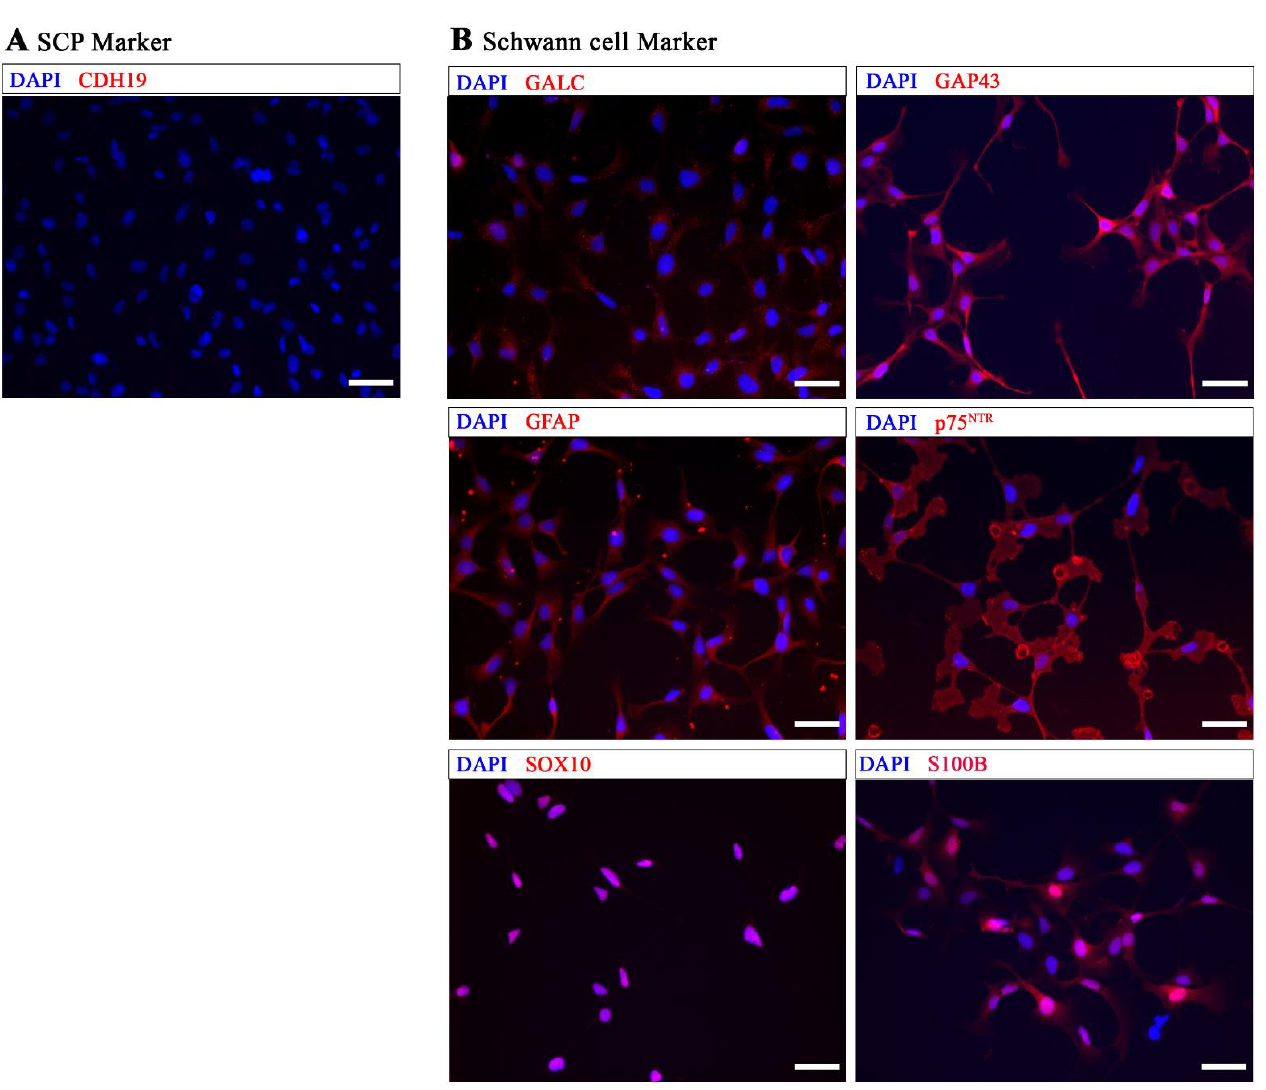
Figure 2. Immunocytochemical analysis of MHH-hiPSC-immatureSCs. ( A ) shows that hiPSC- immatureSCs were negative for CDH19. ( B ) shows positive staining for Schwann cell markers GALC, GAP43, GFAP, p75NTR, SOX10, and S100B. Cell nuclei were stained with DAPI (Blue). Scale bar: 50 µm.